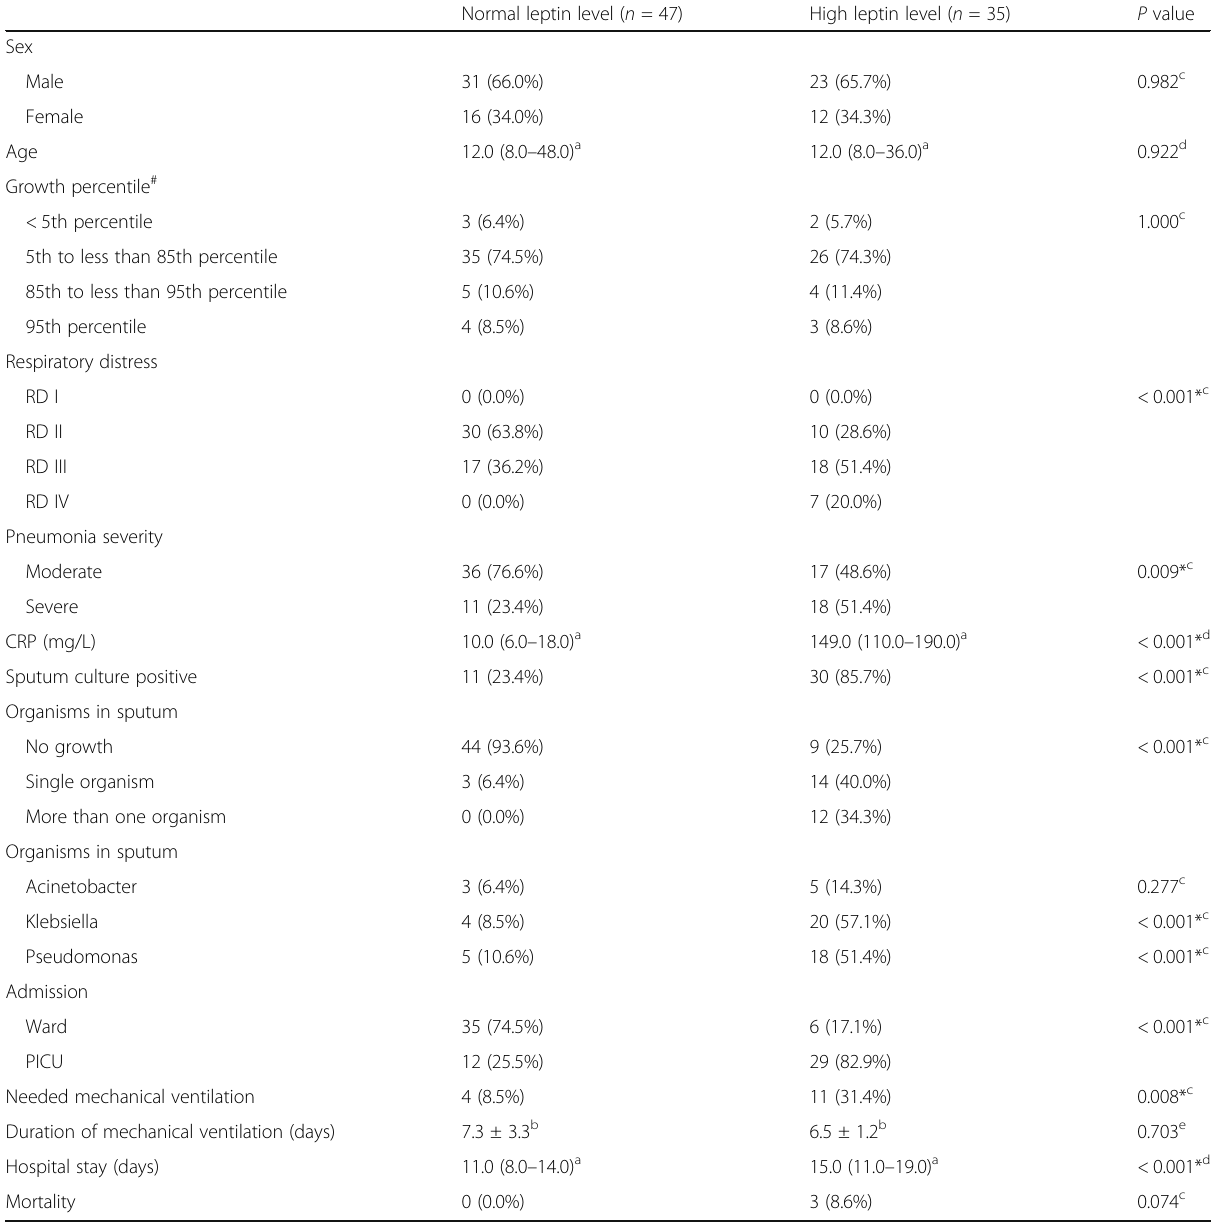
Table 2 Comparison between patients with normal and elevated leptin levels Normal leptin level ( n =